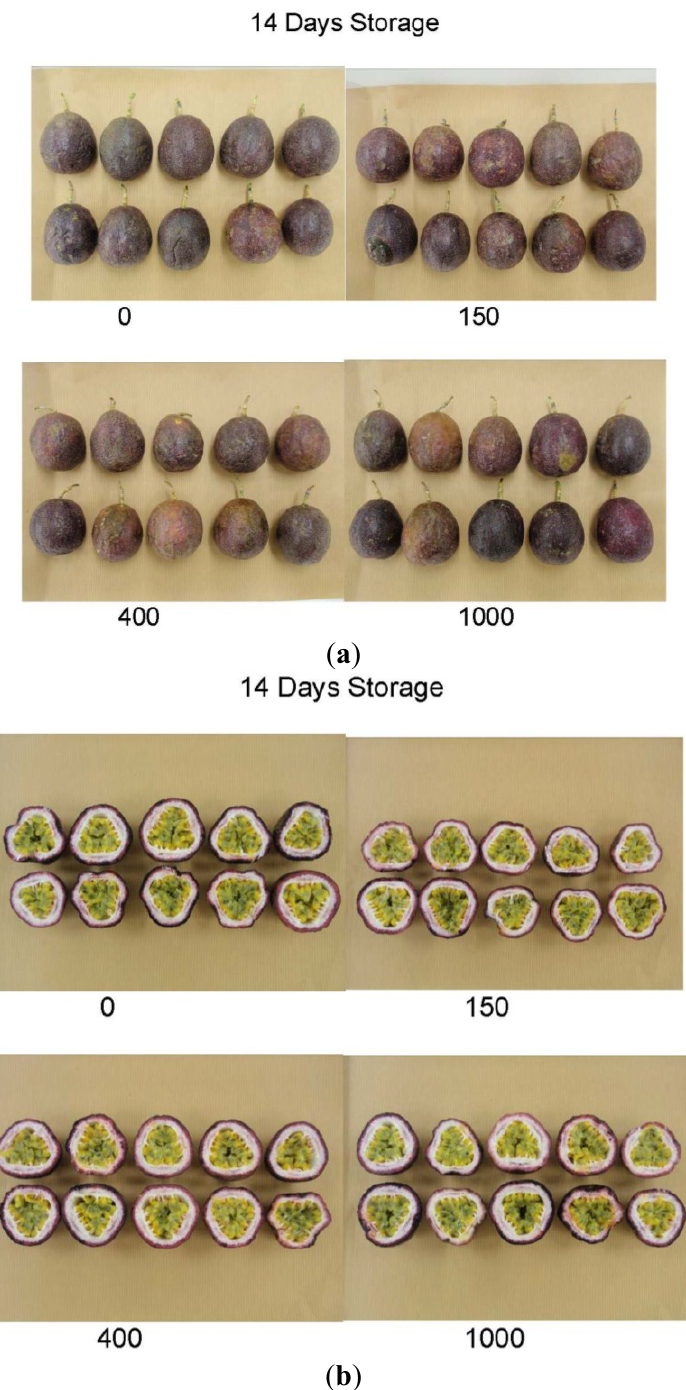
Figure 2. ( a ) Irradiated passionfruit after fourteen days storage at 8 °C. Fruit were treated with 150 Gy (top right), 400 Gy (bottom left) and 1000 Gy (bottom right), or left untreated (0 Gy, top left); ( b ) Irradiated passionfruit after fourteen days storage at 8 °C. Fruit were treated with 150 Gy (top right), 400 Gy (bottom left) and 1000 Gy (bottom right), or left untreated (0 Gy, top